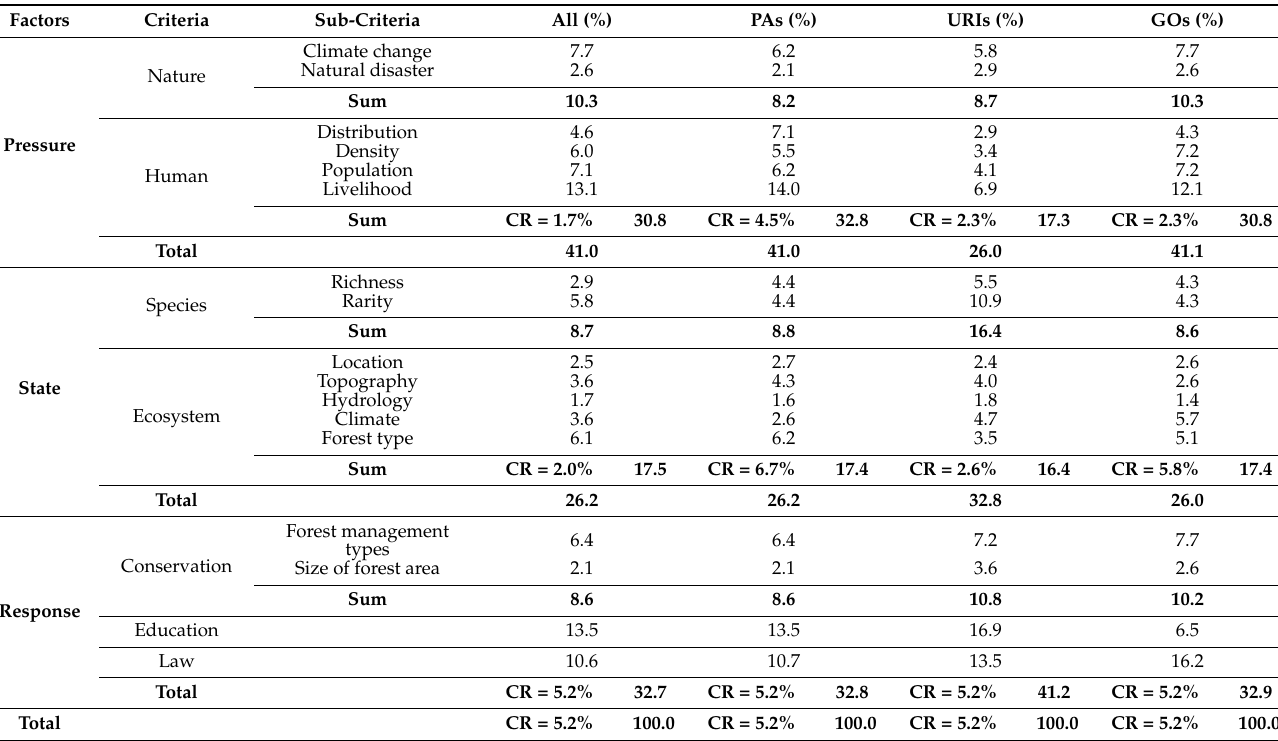
Table 4. Weights of criteria based on all respondents and groups for identifying the priority areas of biodiversity conservation in